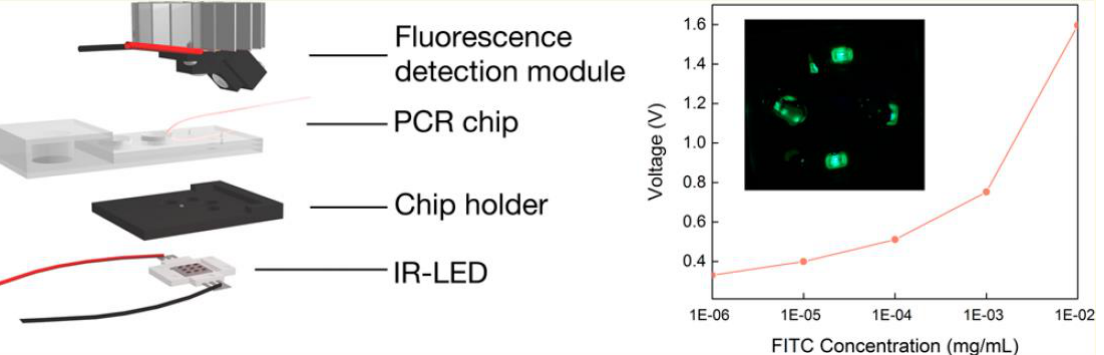
amplification in 70 min.